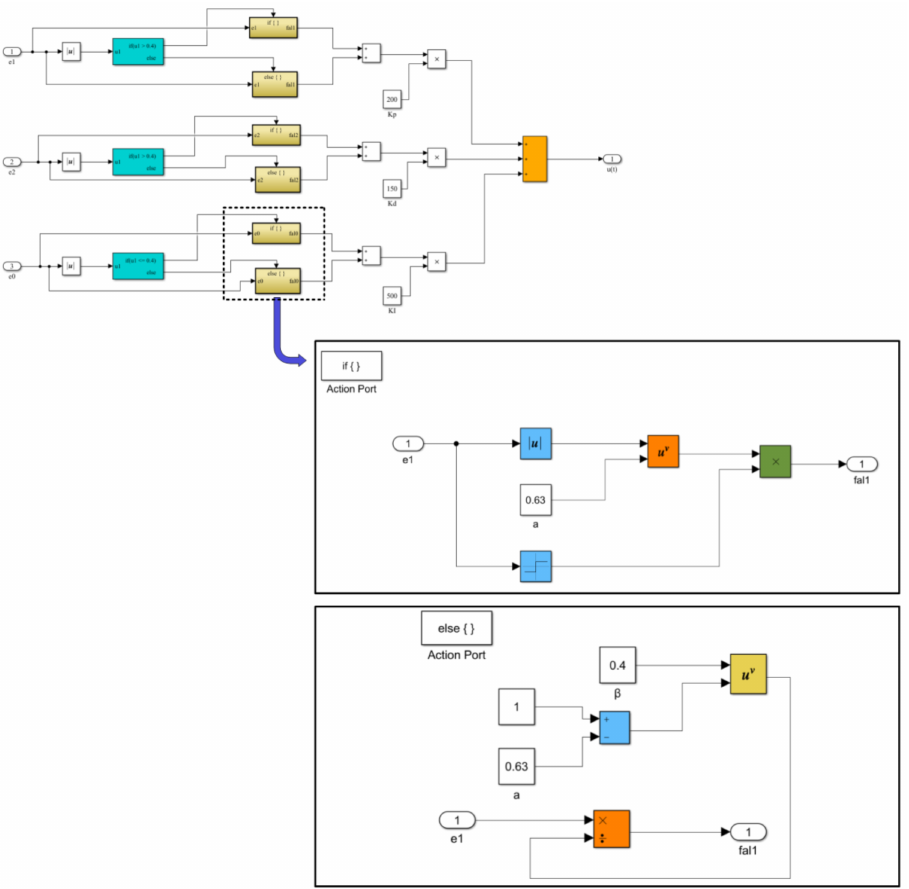
Figure 8. Simulation model of nonlinear